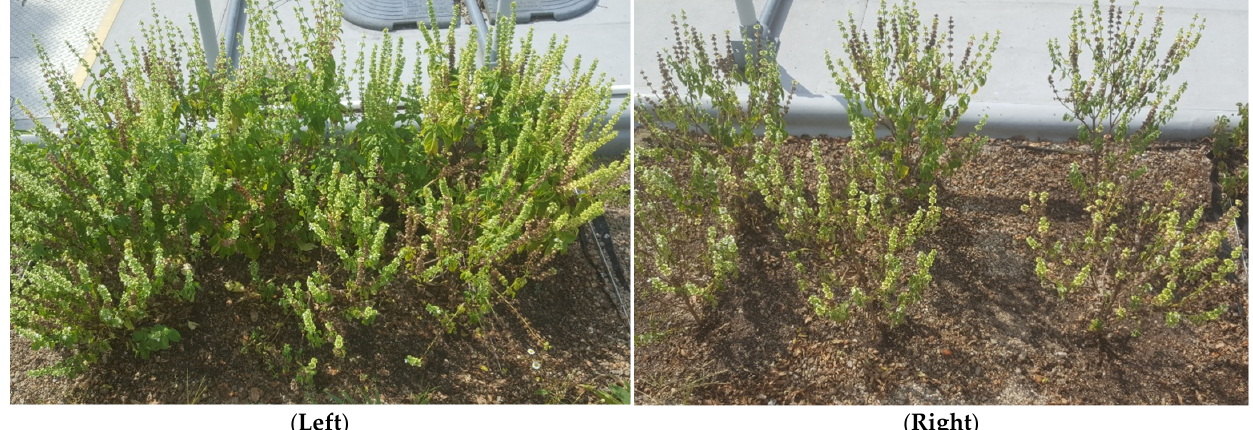
Figure 2. Comparison of watering regime treatments showing the effects of 1 L of water applied twice per week ( left ) and once every 2 weeks ( right ) on resulting basil foliar growth in an extensive green roof environment.